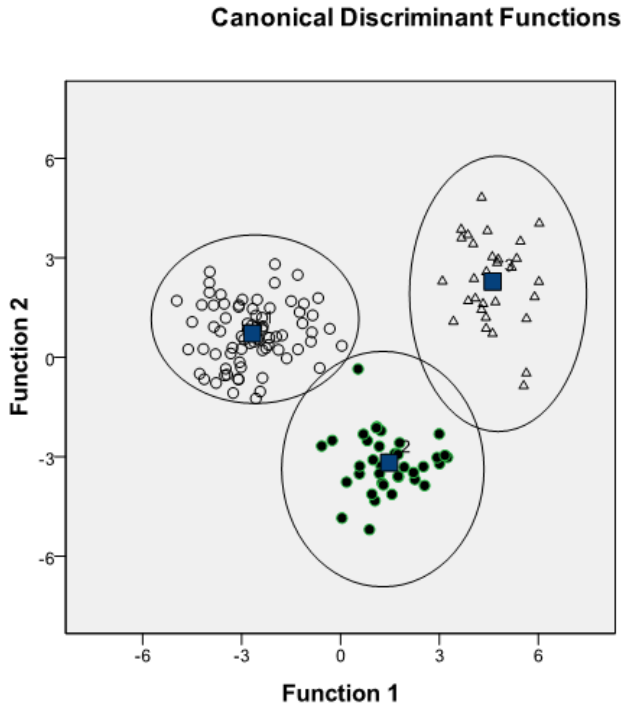
F IGURE 5. Canonical discriminate function analysis of both morphometric and meristic characters of A. qanati.